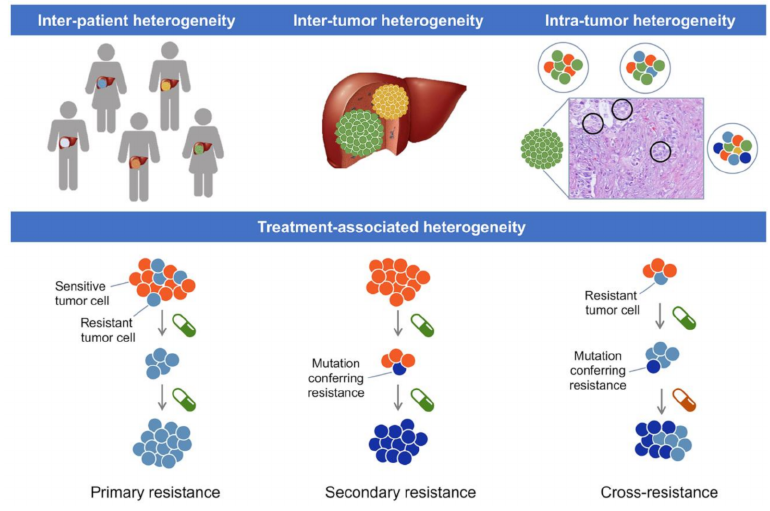
Figure 1. Schematic representation of inter-patient, inter-tumor and intra-tumor heterogeneity in CCA, as well as tumor heterogeneity in response to pharmacological